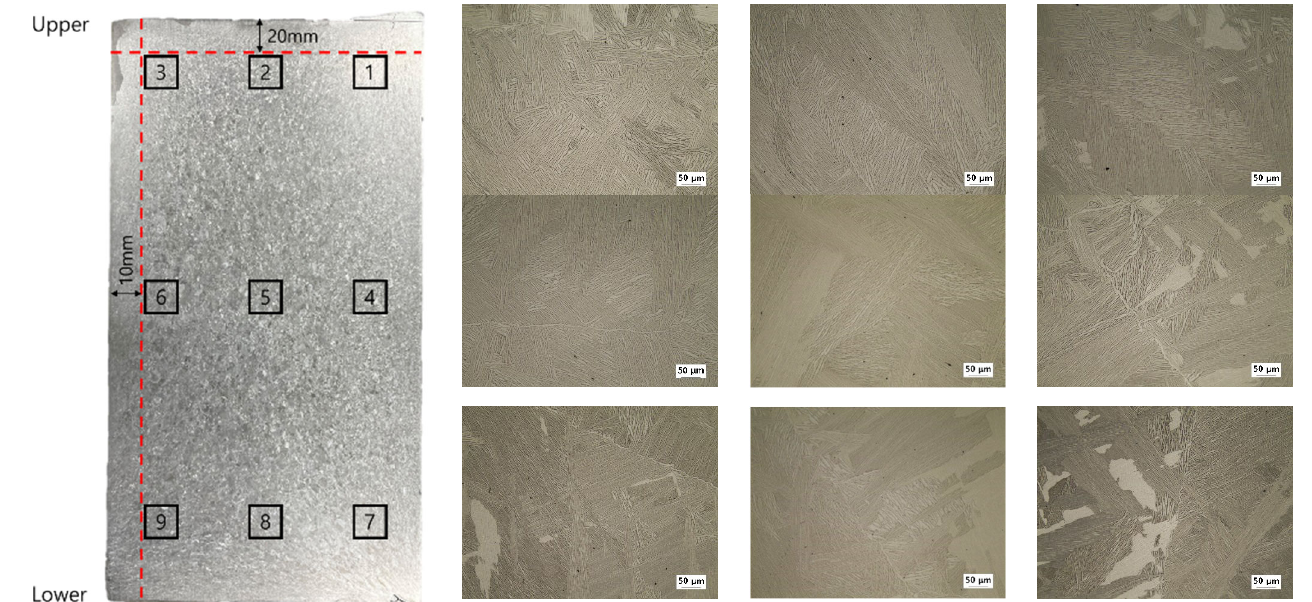
Figure 16. Macrostructure after ring ‐ rolling process of Ti ‐ 6Al ‐ 4V alloy at 1050 °C, 1 (cid:3400) 10 (cid:2879)(cid:2870) /s .